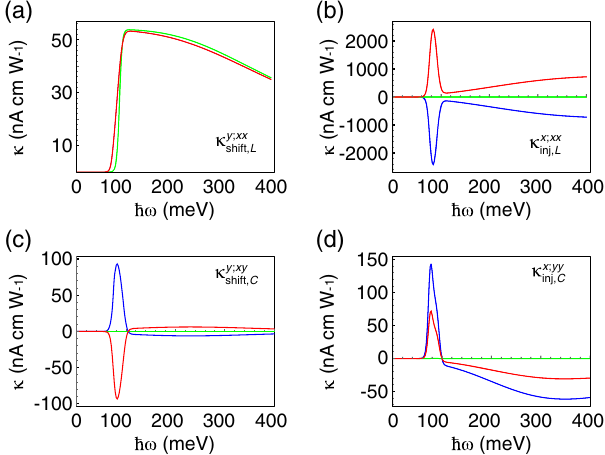
FIG. 3. Photoresponsivity of the magnetic Dirac surface state. Here, μ ¼ 50 meV, m ¼ 0 . 13 m , ℏ v ¼ 2 . 5 eVÅ − 1 , λ ¼ 250 eVÅ − 3 , e and ℏ τ − 1 ¼ 1 meV. Blue, green, and red curves correspond to Δ ¼ 30 meV, 0 meV, and − 30 meV, respectively, and κ c ; ab ¼ 1 nA cmW − 1 is equivalent to σ c ; ab ¼ 1 . 33 pA cm − 1 V − 2